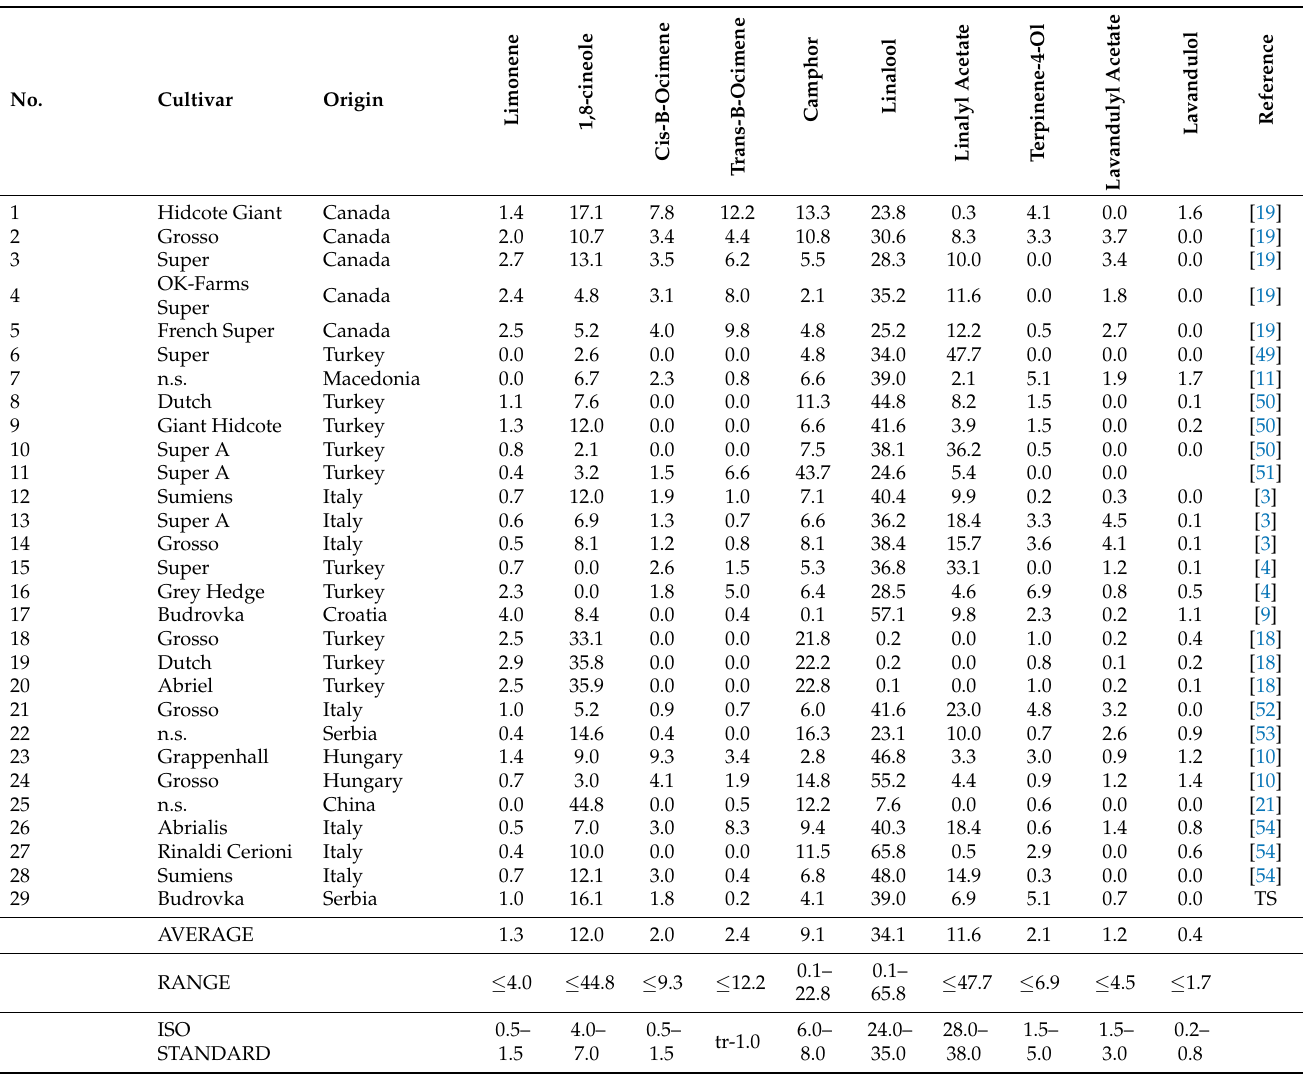
Table 6. Comparison results of main L. x intermedia essential oil components and ISO 8902